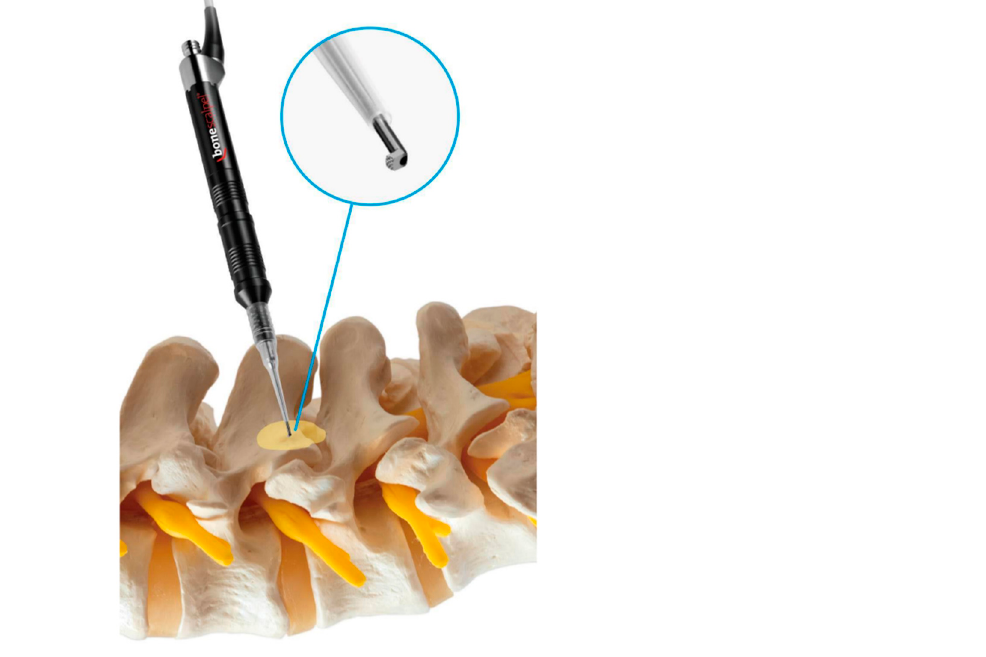
Figure 1. Illustration showing the use of the ultrasonic bone scalpel (UBS) hook type during single- level spinal stenosis decompression. The UBS system provides a strong, safe, and speedy cut during the operation.